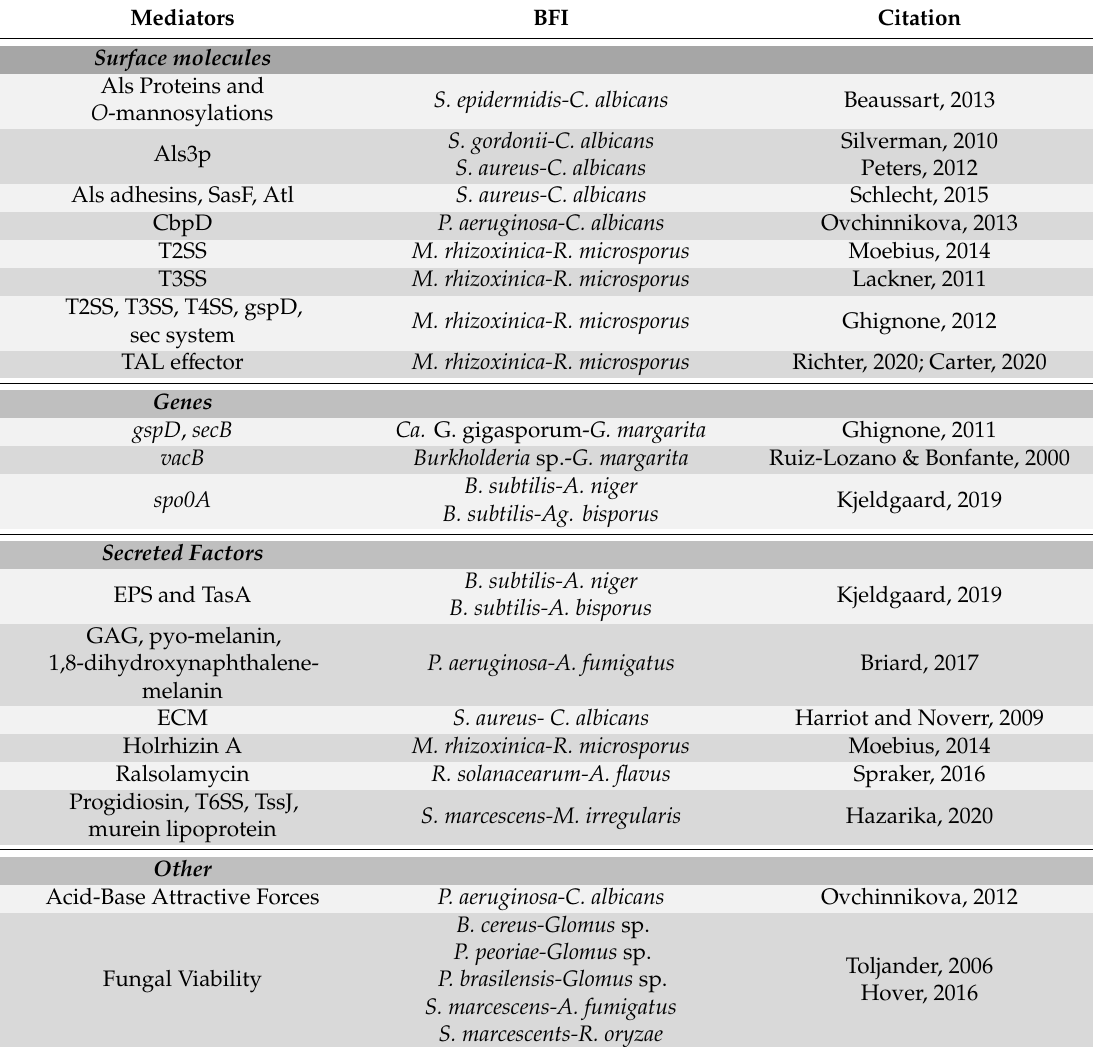
Table 1. Mediators of Bacterial-Fungal Interactions